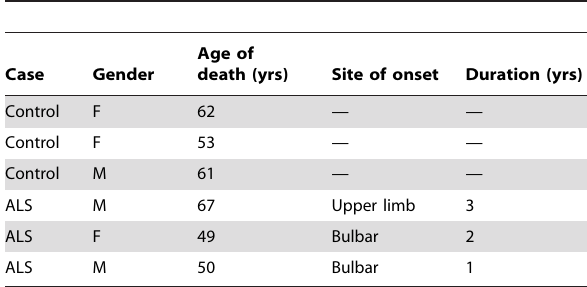
Table 2. Putative novel miRNAs that have predicted response elements [57] within the NEFL mRNA 3 9